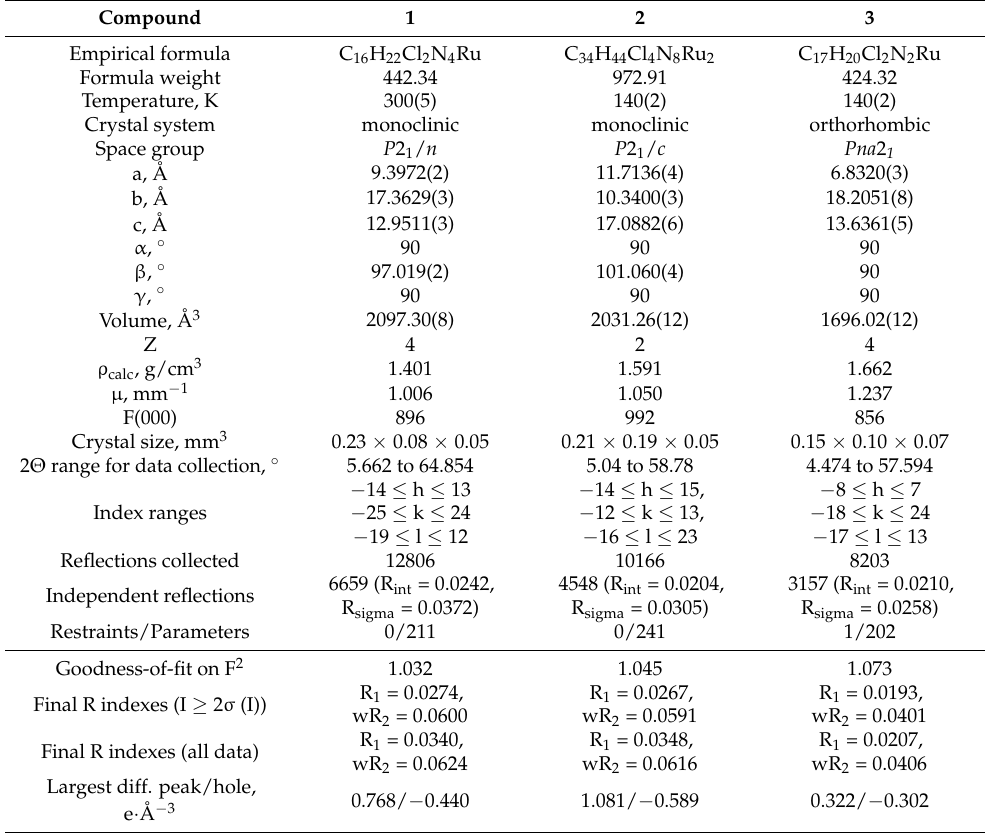
Table 1. Crystallographic data of the compounds 1 – 3